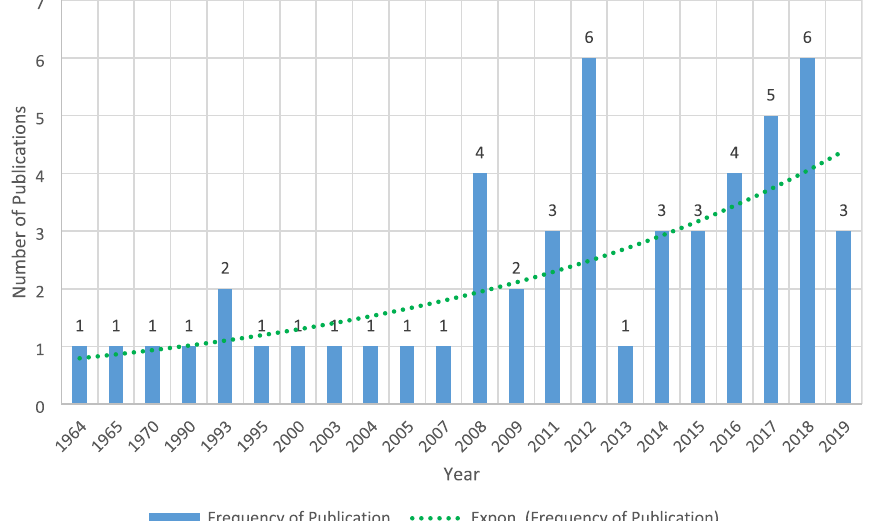
Fig. 2 Frequency of publications by